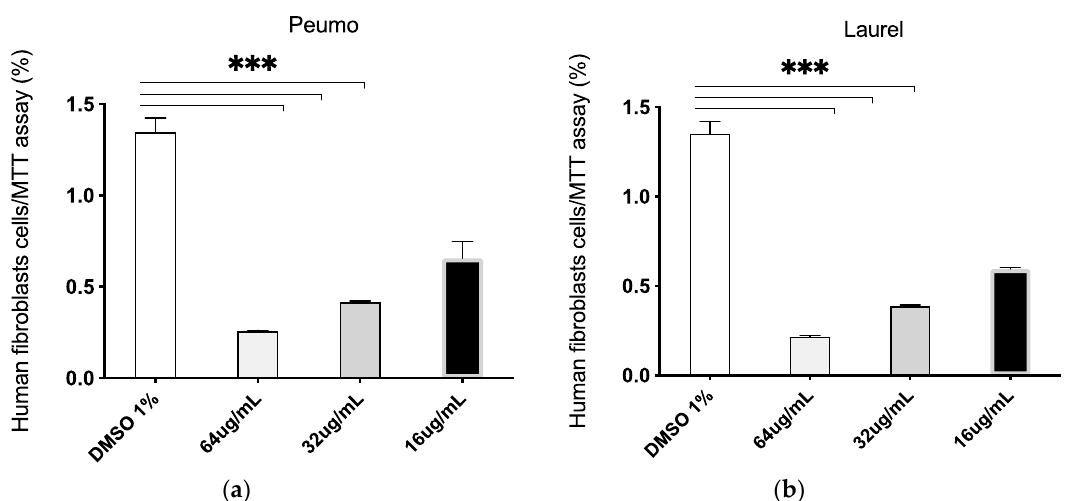
Figure 5. Dose-response curve of human fibroblasts cells treated with Cryptocarya alba (Peumo; CA); Laurelia sempervirens (Laurel; LS) EOs. The graph bar corresponds to the proliferation of fibroblasts cells treated with the Eos ( a . Peumo) and ( b . Laurel), at different concentrations versus control (DMSO 1%) for 48 h, evaluated by MTT assay at 570 nm. Three independent trials were performed, in triplicate, for each treatment and concentration. *** p < 0.001.